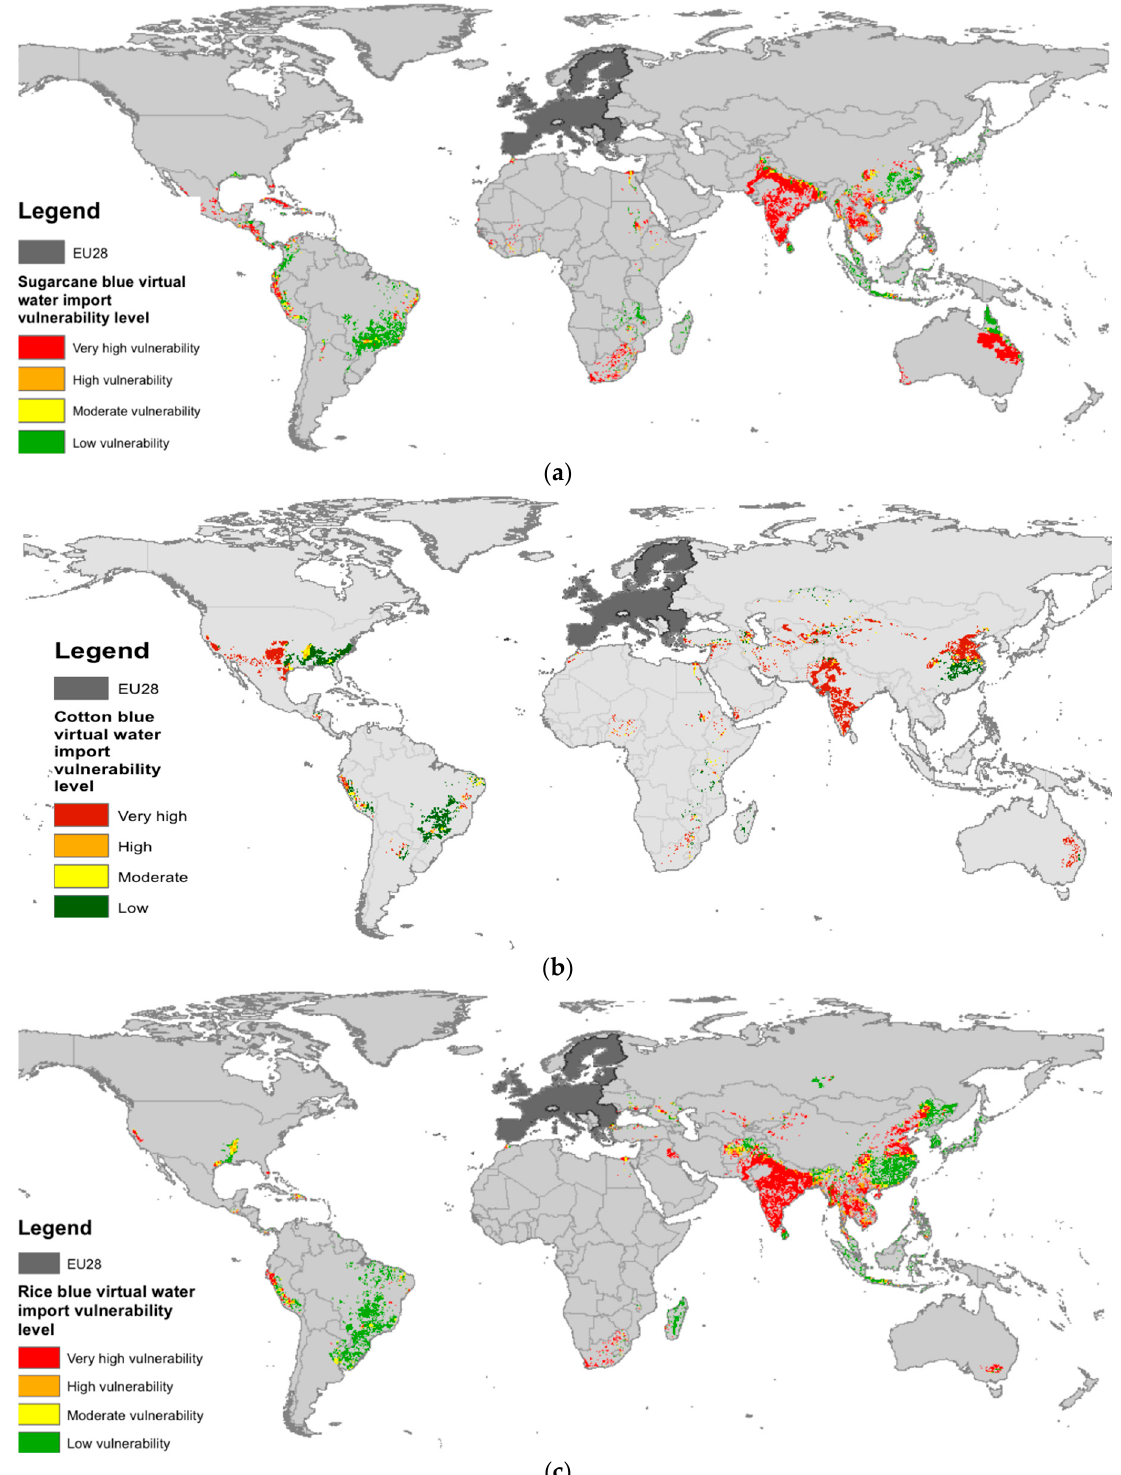
Figure 9. Vulnerability maps for blue virtual water imports to the EU for sugarcane ( a ), cotton ( b ) and rice ( c ).